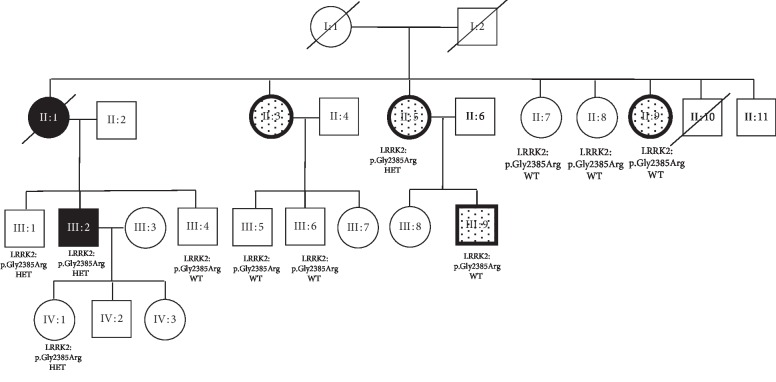
Familial case with p.Gly2385Arg variant. III:2 Proband 40 years old, PD onset at 38 years. II:1 Affected mother of the proband. PD onset at 55 years. Died at 58 years. Levodopa responsive PD. II:3 affected maternal aunt. 10 years' history of unilateral right-hand tremor at rest and action. II:5 Affected maternal aunt, 54 years old. 10 years' history of positional unilateral tremor. III:9 son of II:5. Right-hand positional tremor. II:9 Affected maternal aunt, 4-5 years' history of right-hand positional tremor.